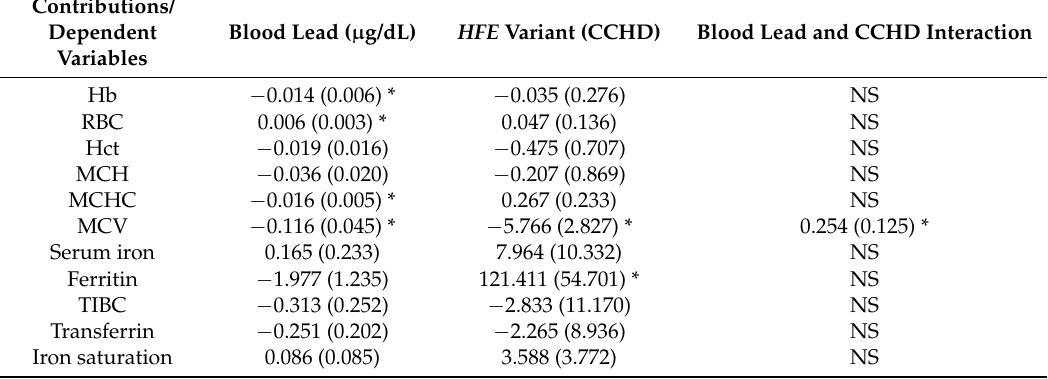
Table 3. The contributions and interactions of blood lead and the HFE variant, which were determined by a multiple linear regression model adjusted for age, BMI, and smoking and drinking